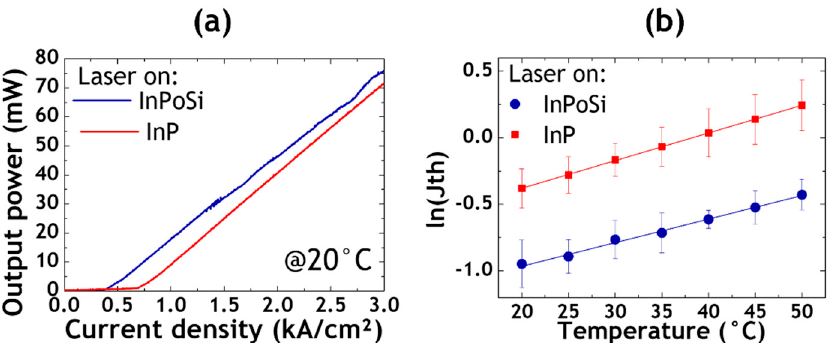
Figure 6. Light-current characteristics comparison between the laser grown on InPoSi (blue) and for ◦ C; ( b ) evolution of the threshold current density up to 50 ◦ the one grown on InP (red): ( a ) at 20 °C; ( b ) evolution of the threshold current density up to 50 °C. the one grown on InP (red): ( a ) at 20